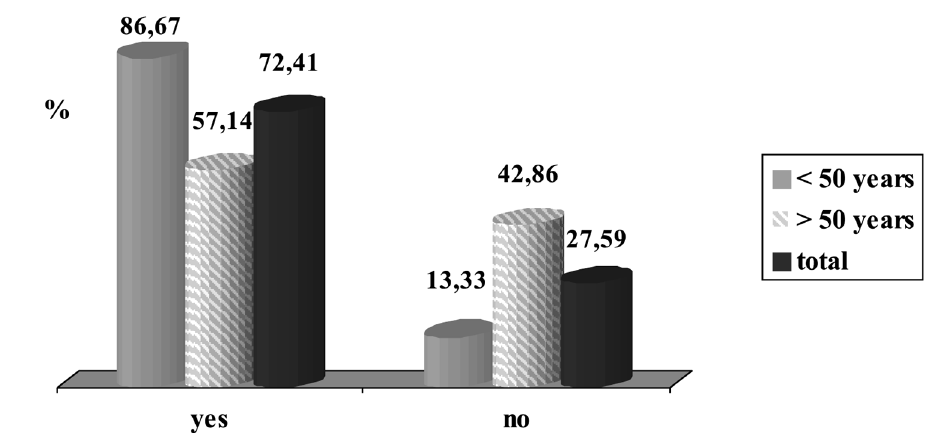
Figure 2 – Global response to sildenafil citrate according to